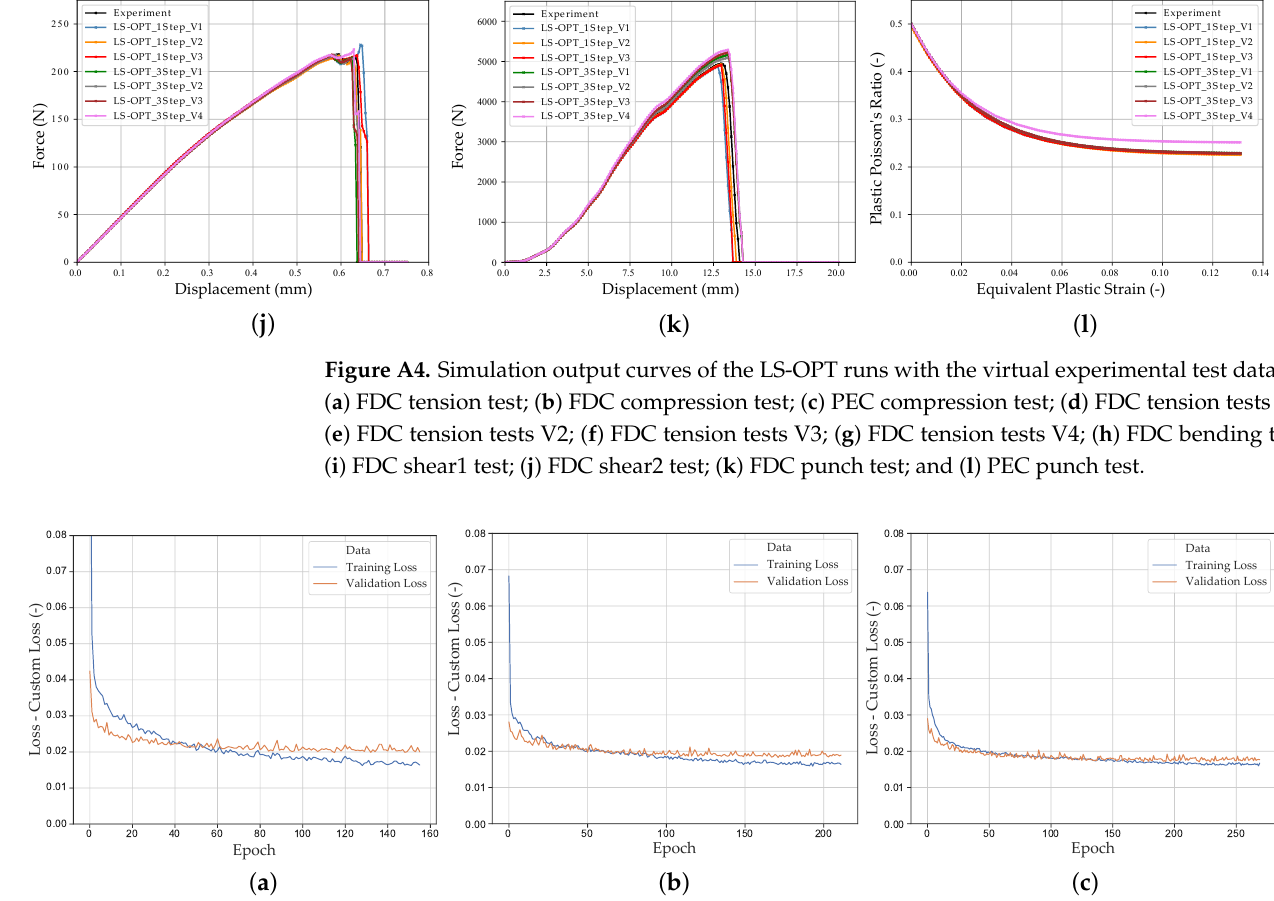
Data Training Loss Validation Loss